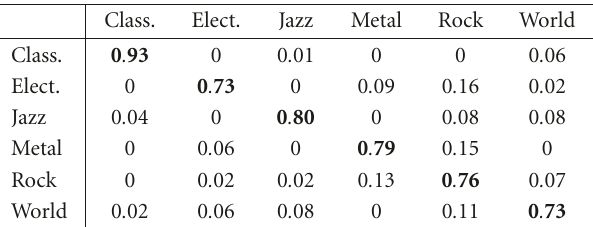
Table 3: Results using the Magnatune database. Class. Elect. Jazz Metal Rock World Class. 0 . 93 0 0 . 01 0 0 0 . 06 Elect. 0 0 . 73 0 0 . 09 0 . 16 0 . 02 Jazz Metal Rock 0 . 07 World 0 . 02 0 . 06 0 . 08 0 0 . 11 0 .